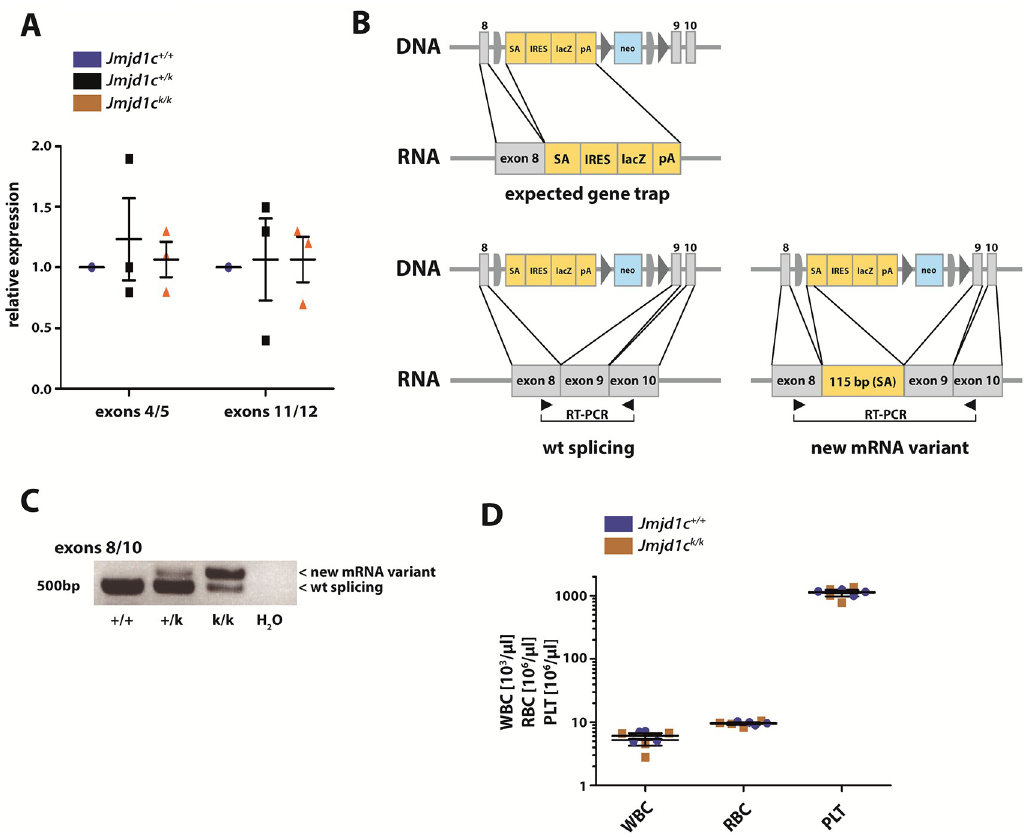
Fig 2. The knockout first approach leads to alternative splicing and a new mRNA variant in Jmjd1c k/k mice. (A) RT-qPCRs spanning exons 4/5 and 11/12 with cDNA obtained from whole embryos. (B) Expected and observed mRNA variants in mice carrying the k allele. (C) RT-PCR spanning exons 8/10 with cDNA obtained from whole embryos. Bands were cut out and extracted DNA was sequenced (S5 Fig). (D) PB count of 12-week-old Jmjd1c +/+ and Jmjd1c k/k mice (n = 4 per genotype). Mann- Whitney U test was used for statistical calculations. Data are represented as mean +/-